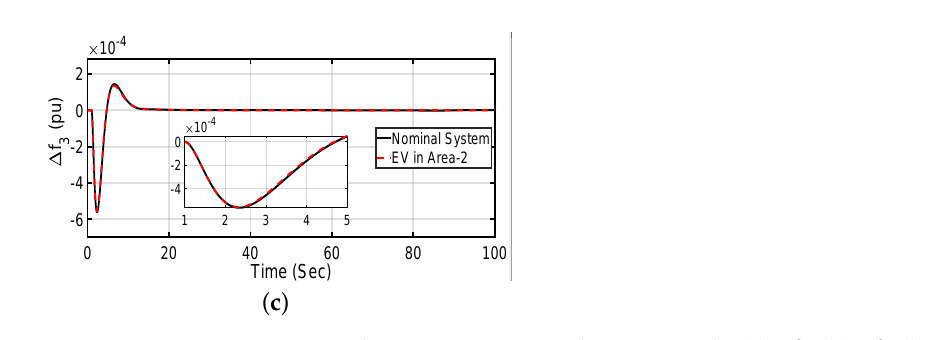
Figure 9. Response comparison when EVs are connected in Area 2 only. ( a ) ∆ f 1 ; ( b ) ∆ f 2 ; ( c ) ∆ f 3 .